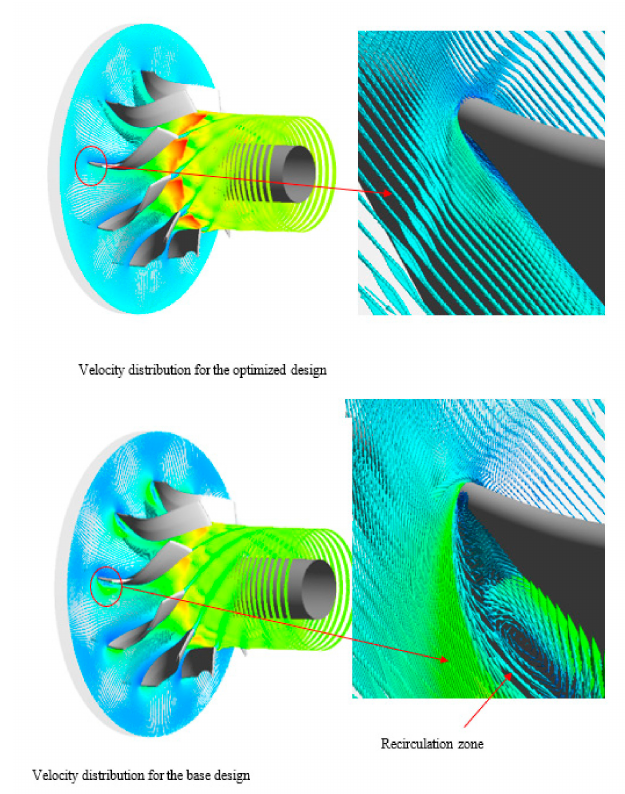
Figure 16. Velocity vectors on 50% span for the base and optimized design.